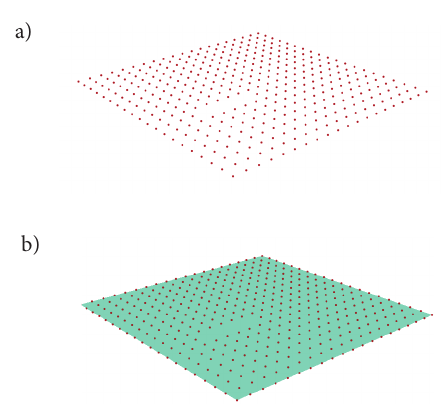
Fig. 1. The points cloud with gross errors: a – graphical representation of the points cloud; b – graphical